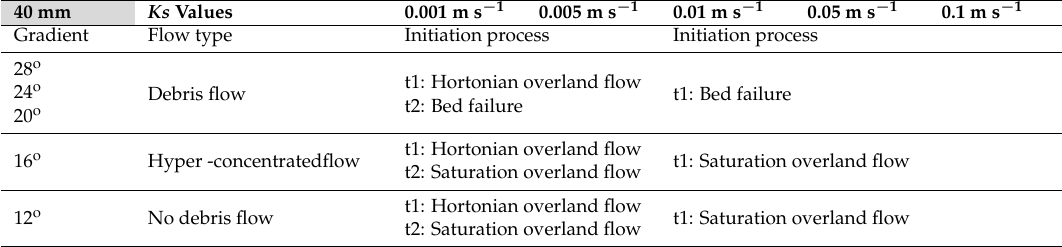
Table 5. Sequence of different initiation processes for debris (hyperconcentrated) flows in relation to the hydraulic conductivity and slope of the channel bed material. Simulated rain intensity is 40 mm. 40 mm Flow